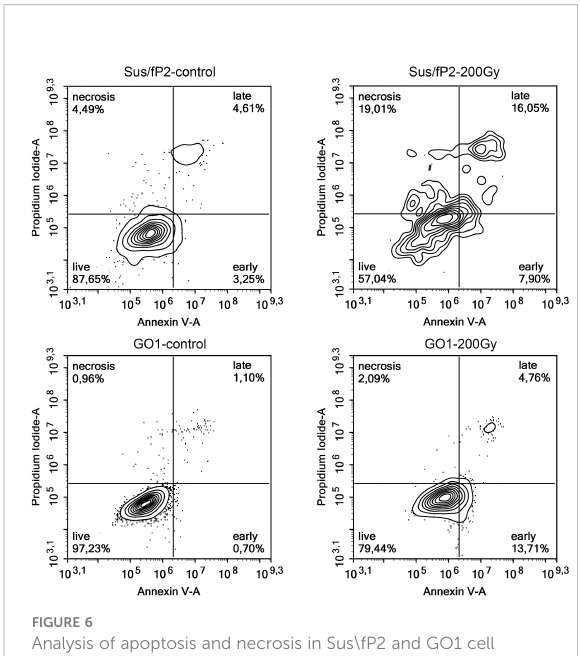
FIGURE 6 Analysis of apoptosis and necrosis in Sus\fP2 and GO1 cell cultures exposed to 200 G g .